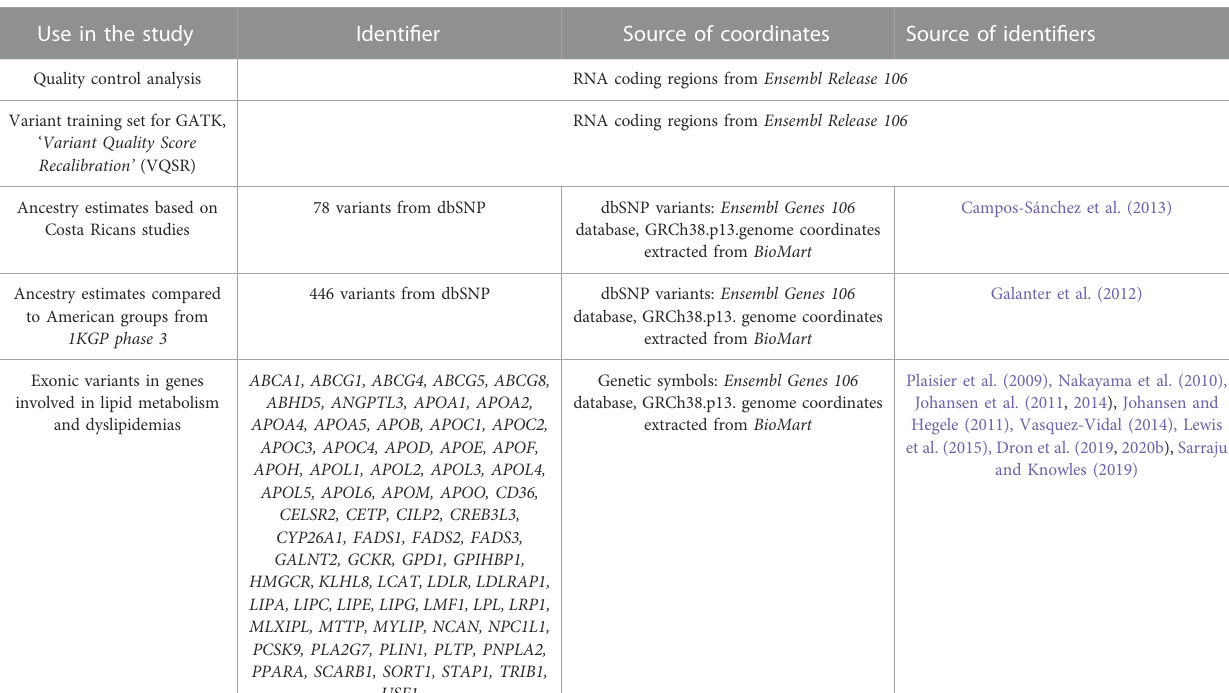
TABLE 1 Genomic coordinates selected for variant